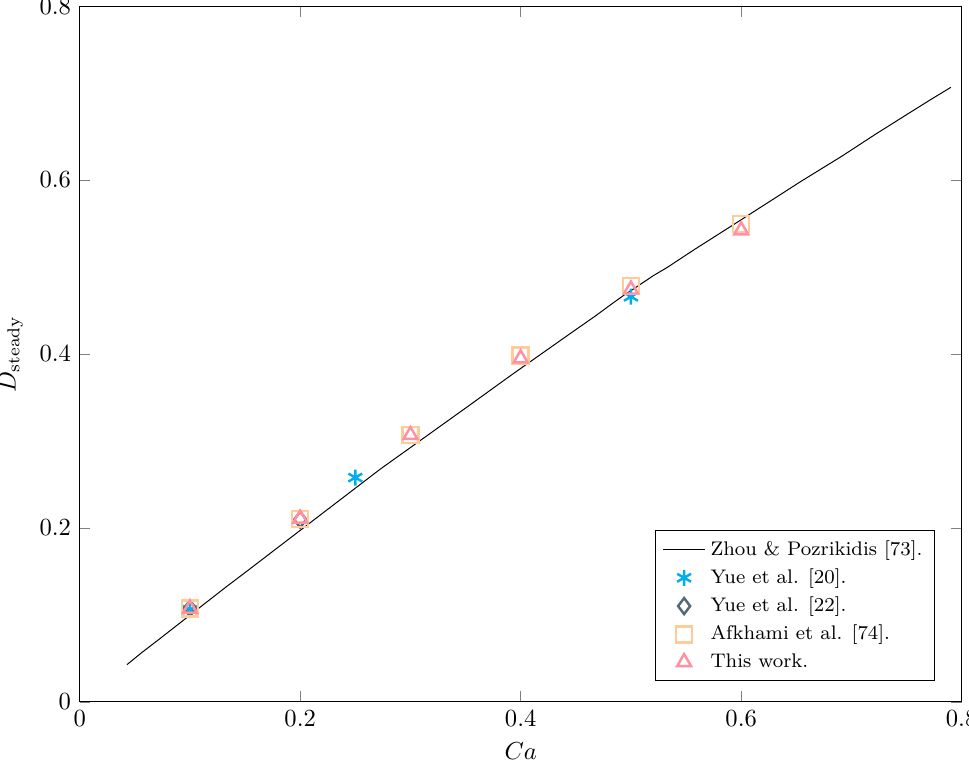
Figure 2. Comparison of the steady-state deformation of a Newtonian drop in a Newtonian matrix between our results and those found in Zhou & Pozrikidis [73], Yue et al. [20,22], and Afkhami et al.